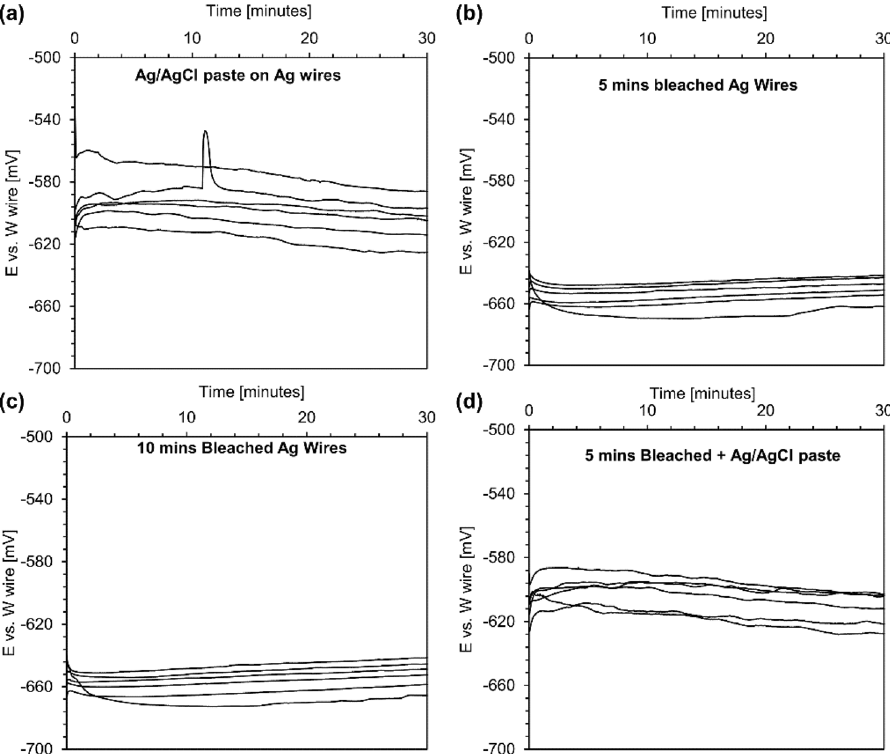
Figure 2. The stability evolution of custom-made reference electrodes: ( a ) real-time response of silver wires coated with silver/silver chloride paste versus a tungsten wire in a buffer with the pH of 10 for 30 min-RE1, ( b ) real-time response of 5-min bleached silver wires versus a tungsten wire in a buffer with the pH of 10 for 30 min-RE2, ( c ) real-time response of 10-min bleached silver wires versus a tungsten wire in a buffer with the pH of 10 for 30 min-RE3, and ( d ) real-time response of 5-min bleached silver wires + silver/silver chloride paste versus a tungsten wire in a buffer with the pH of 10 for 30 min-RE4. N =